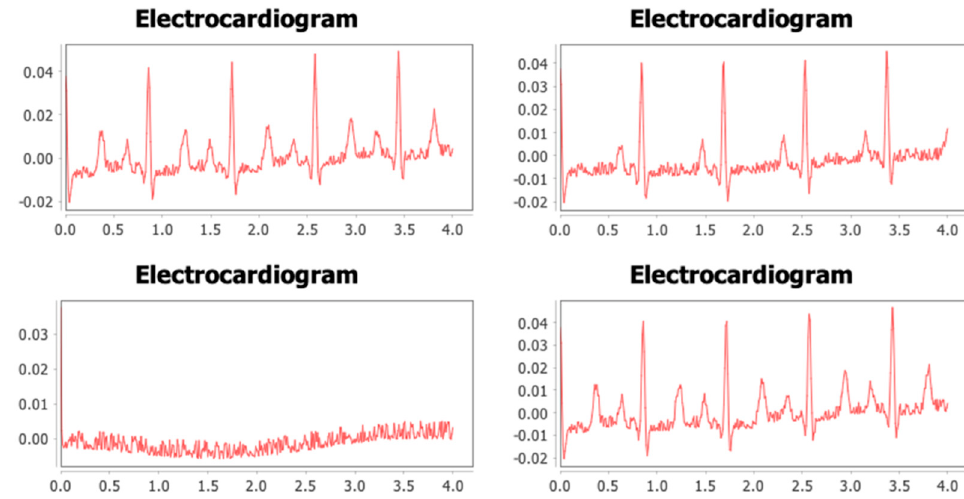
Figure 6. Four examples of synthetic single-node ECGs incorporated into the synthetic patient records. Examples show a clinically normal reading ( upper left and lower right ), non-specific ST-T wave changes ( upper right ), and the absence of a sinus rhythm reading ( lower left ). The readings contain significant artifact, which can also appear in non-synthetic ECGs due to patient movement, electromagnetic interferences, or electrode malfunctions.